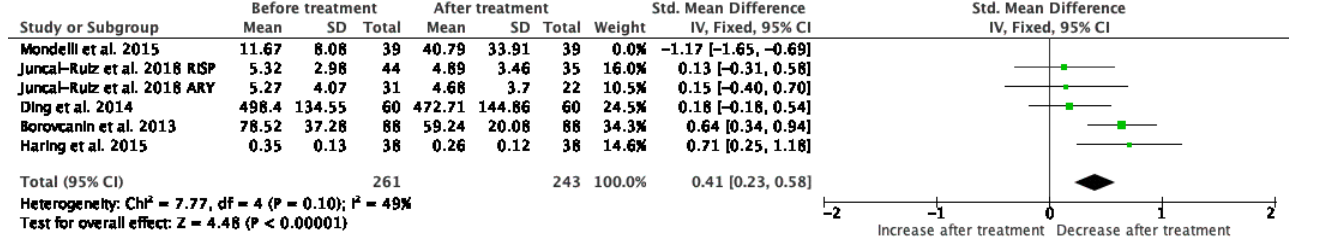
Figure 7. Meta-analysis of IFN- γ .